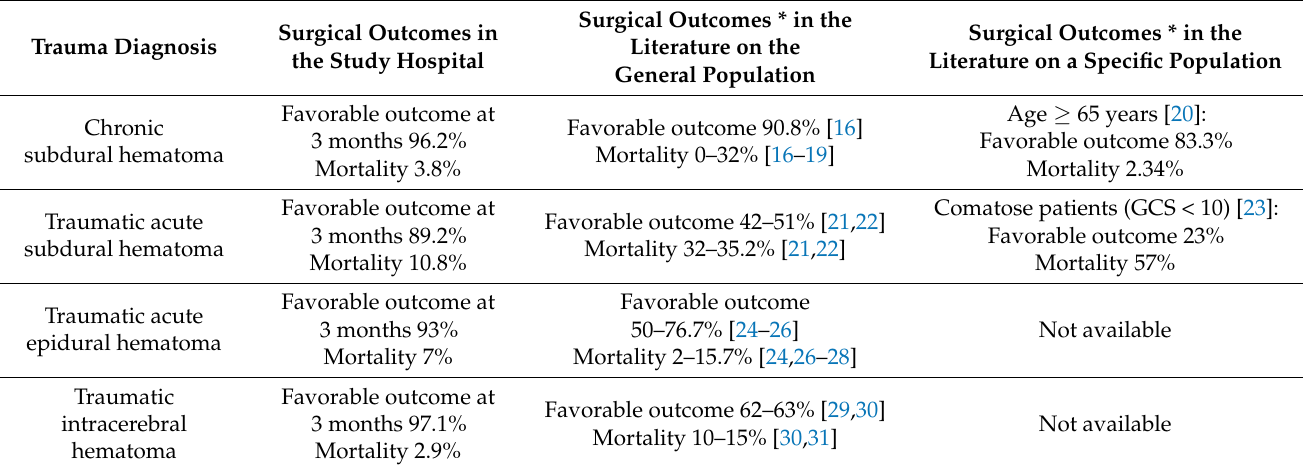
Table 5. Summary of the literature comparisons of the surgical